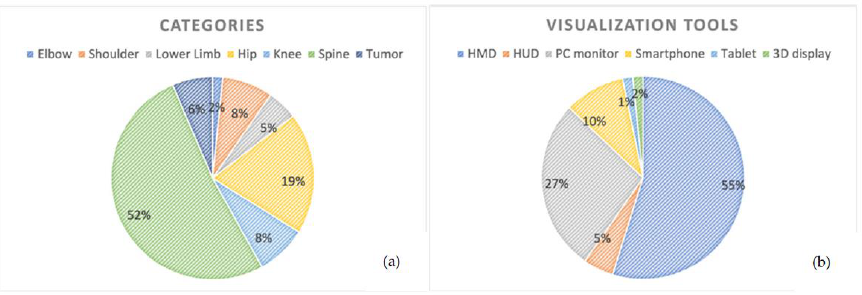
Figure 2. Diagrams resume percentages of the anatomical districts of interest considered in the reviewed studies ( a ) and type of visualization tool used ( b